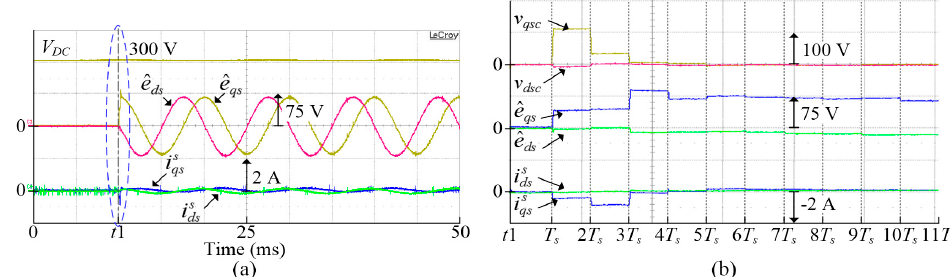
Figure 14. ( a ) Current responses when the back - EMF was decoupled and the initial controller voltage was set to the value calculated by (32) and (33) (the motor speed was regulated at 3000 rpm by the load motor); ( b ) Amplified waveforms around t 1 . Table 2. Measured currents at various positions when the restarting strategy is implemented.